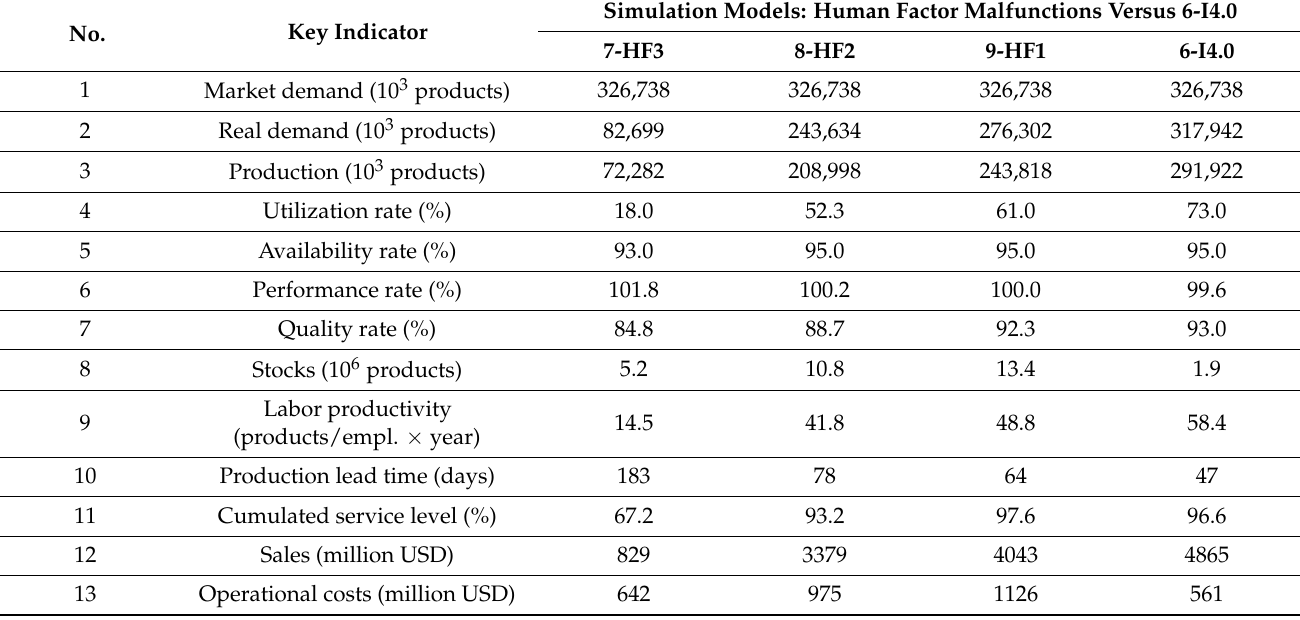
Table 3. Simulation results for the high demand level